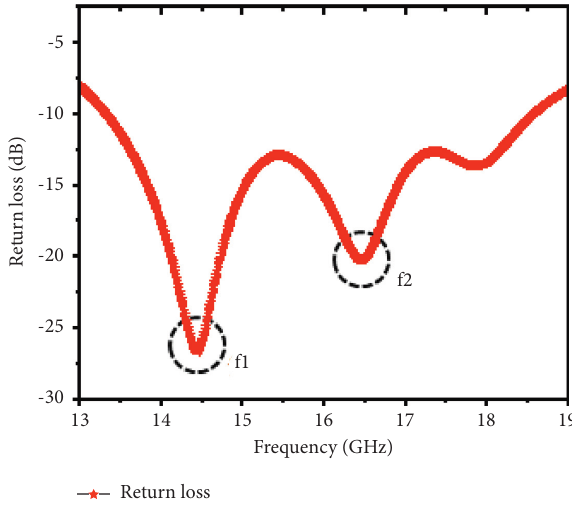
Figure 4: The proposed S